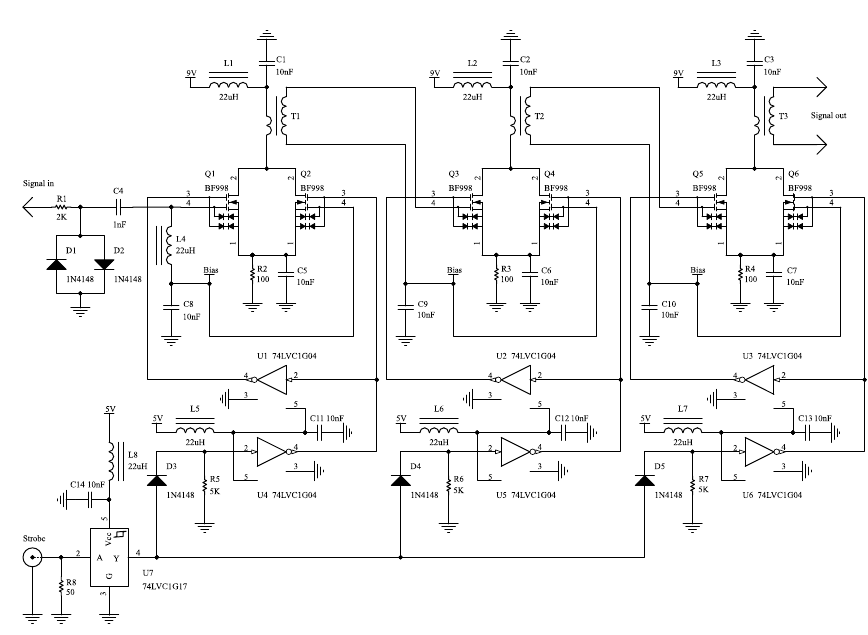
Figure 6. The circuit diagram of the proposed gated amplifier.